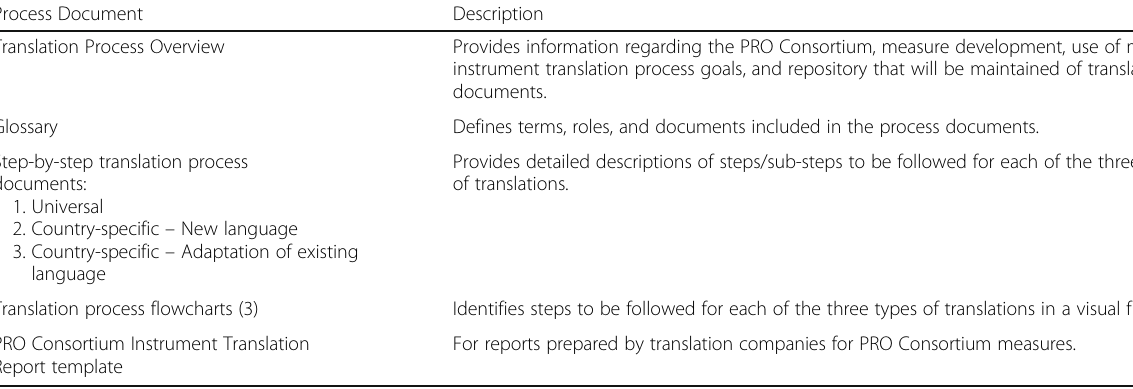
Table 2 PRO Consortium Instrument Translation Process Documents Process